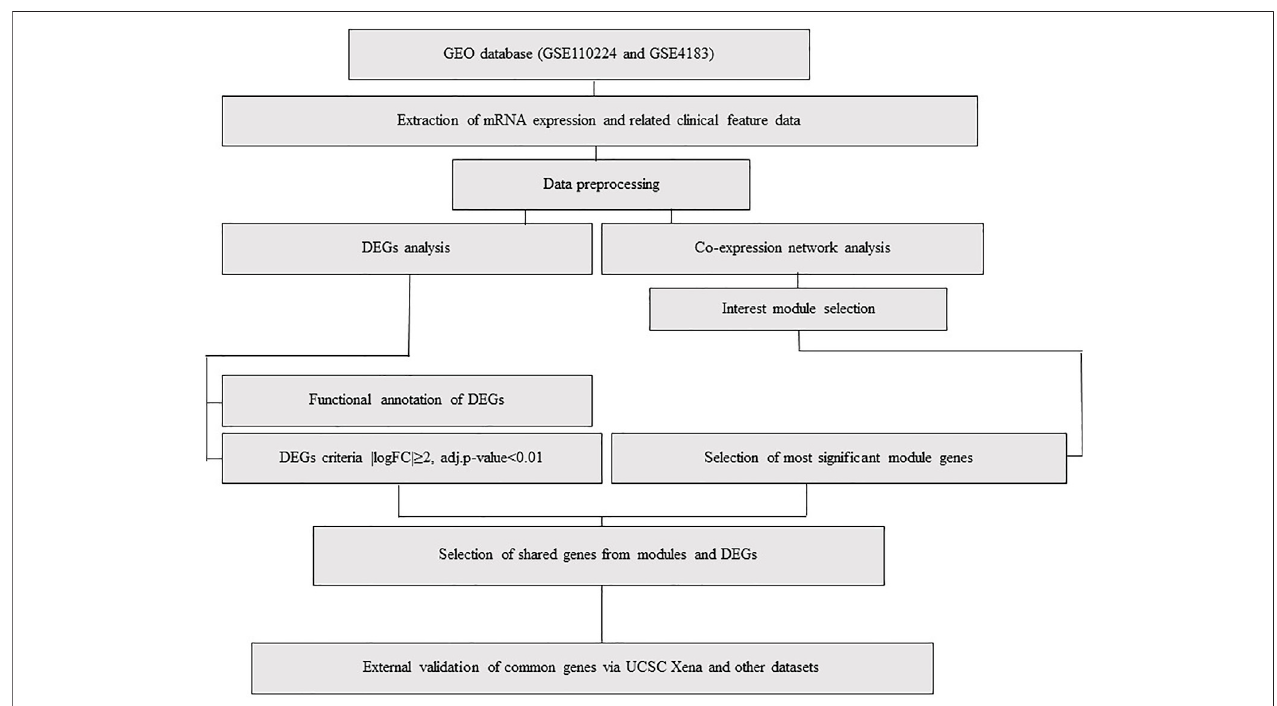
FIGURE 1 | Flowchart, including data preparation, processing, and analysis of CRC and IBD datasets. The CRC dataset (GSE110224) includes 17 CRC samples and 17matched normal samples from each patient ( n = 34). The IBD dataset (GSE4183)includes eight normal colontissue samples and 15colon IBDsamples( n